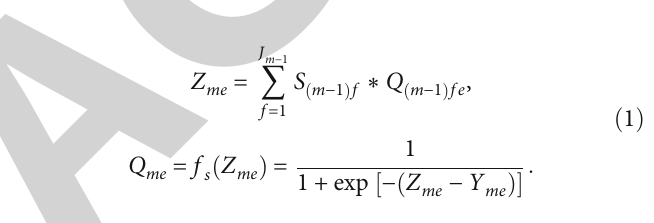
Figure 2: Schematic diagram of arti fi cial neural network